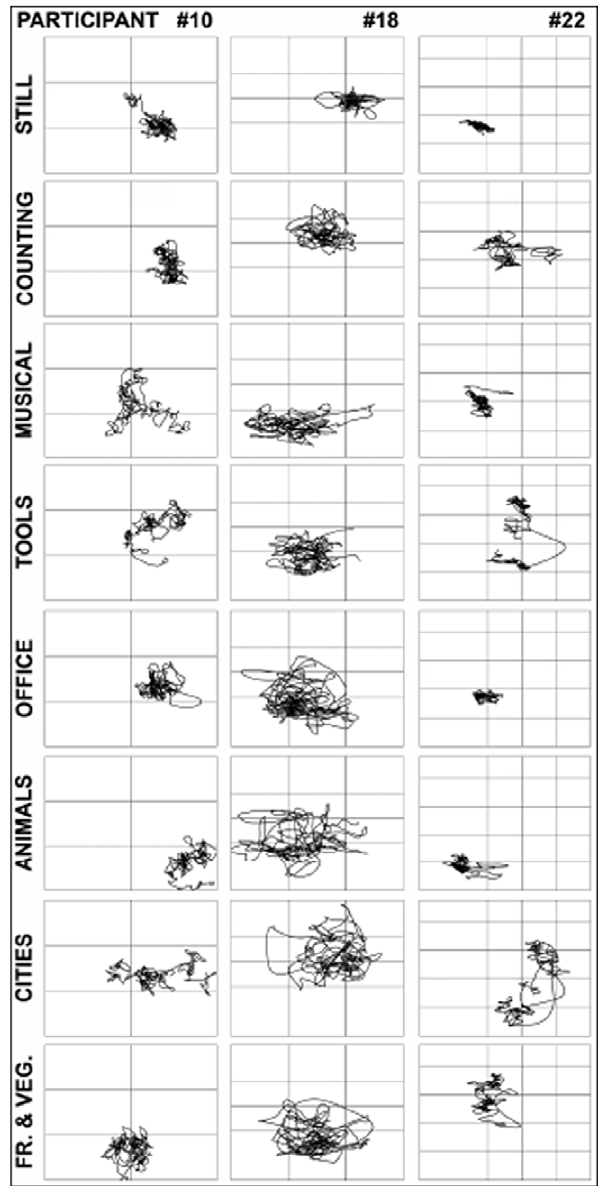
Figure 1. Depiction of COP displacement by semantic condi- tion. Note: This figure shows center of pressure (COP) displacements for three selected participants. As described in detail in the method section, the COP displacement is the absolute value of the distance traveled every 100 ms of the COP during each of the eight conditions (i.e., silent standing, Baseline Motor condition, Semantic-Motor condi- tions and Semantic-Other conditions). Note the larger displacement area within each participant during the Semantic-Motor conditions when compared to the Semantic-Other conditions.